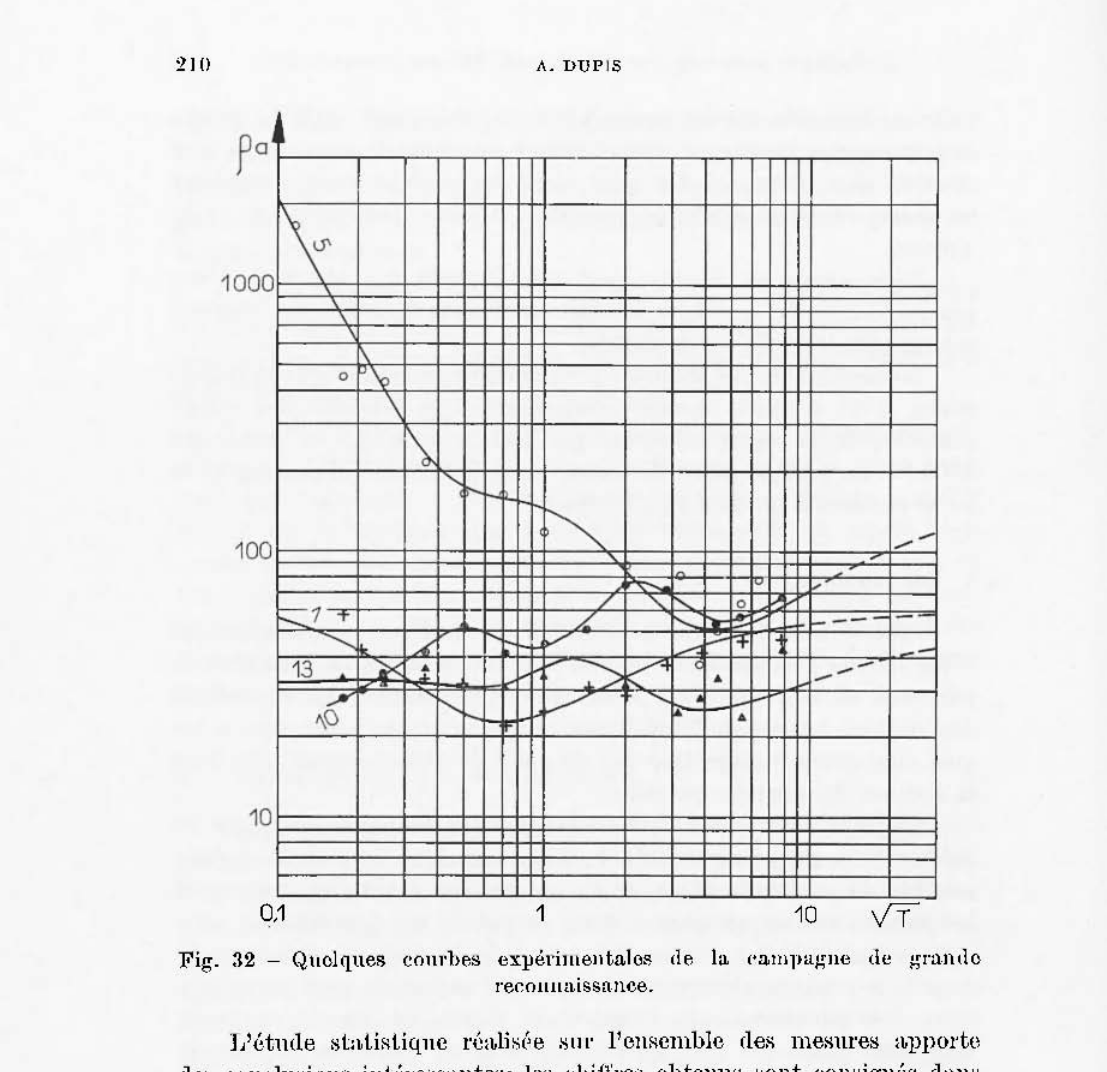
Fig. 32 - Quolques conrhes expé\'illlentalos de la ('alllTJaglle de gnllHlo